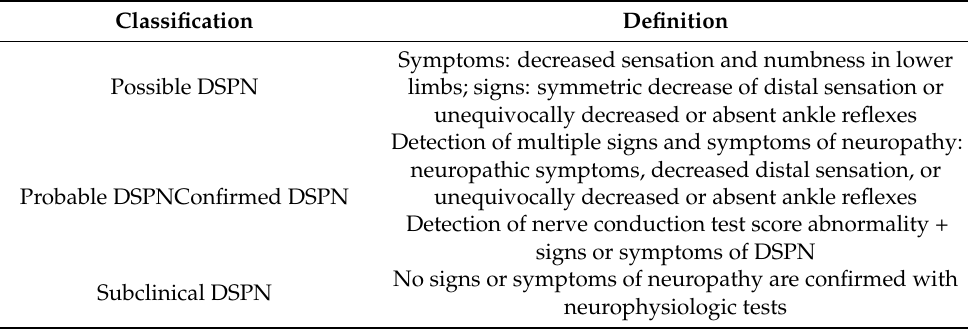
Table 1. Minimal criteria for typical diabetic peripheral neuropathy. Classification Definition Symptoms: decreased sensation and numbness in lower Possible DSPN limbs; signs: symmetric decrease of distal sensation or unequivocally decreased or absent ankle reflexes Detection of multiple signs and symptoms of neuropathy: neuropathic symptoms, decreased distal sensation, or Probable DSPNConfirmed DSPN unequivocally decreased or absent ankle reflexes Detection of nerve conduction test score abnormality + signs or symptoms of DSPN No signs or symptoms of neuropathy are confirmed with Subclinical DSPN neurophysiologic